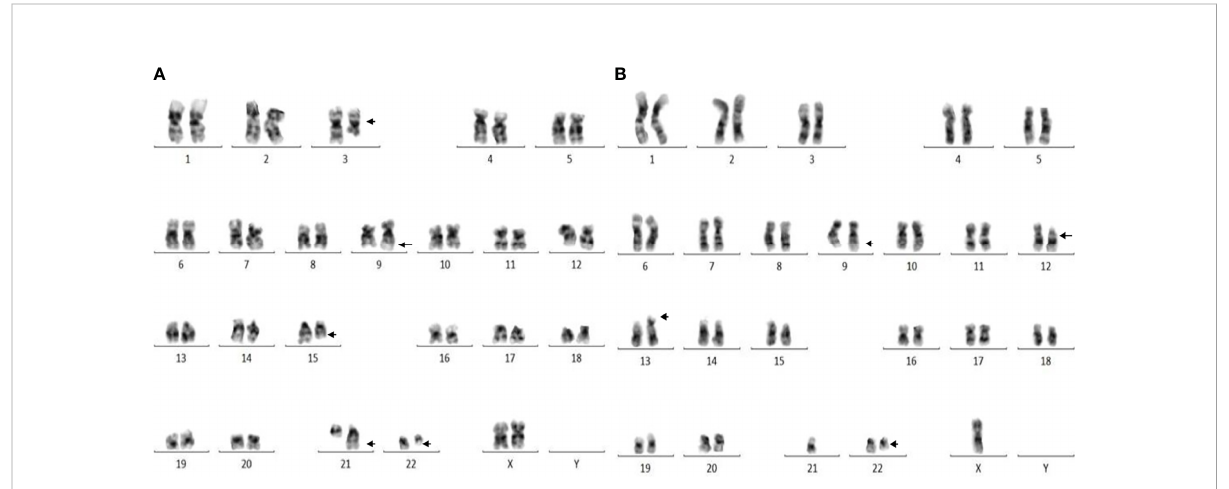
FIGURE 1 (A) Complex karyotype (patient #26) showing 46,XX,t(9;22)(q34;q11),t(3;15;21)(q25;q22;q22) pattern. (B) Complex karyotype (patient # 37) showing 44,X,-Y,t(9;22)(q34;q11),del(12)(p12),der(13;21)(q10;q10)